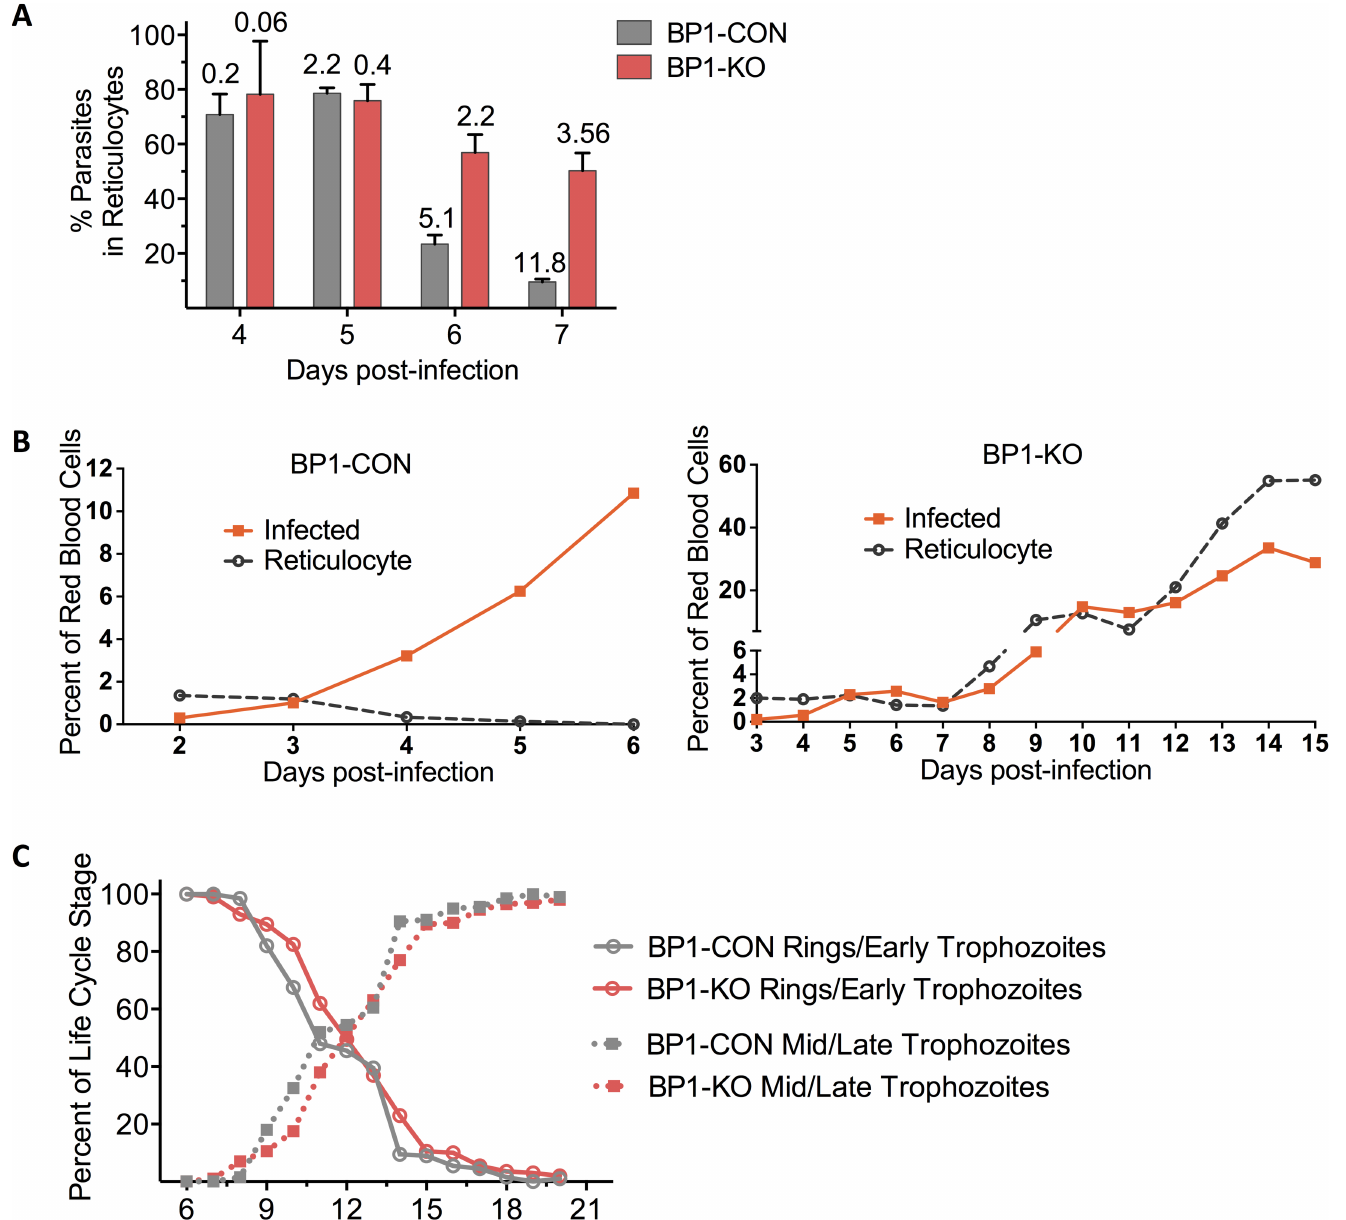
Fig 7. Berghepain-1 is important for normocyte invasion by blood stage parasites. A. Reticulocyte preference of berghepain-1 knockout parasites. Swiss Webster mice were infected with 10 4 purifiedBP1-CON and BP1-KO blood stage schizonts and infected normocytes and reticulocytes were counted starting 4 days after infection. Shown is the percentageof parasites found in reticulocyteson days 4–7 post infection. Each bar shows the mean plus standarddeviationof 5 mice (BP1-CON) and 10 mice (BP1-KO), the latter being pooleddata from BP1-KO clone 1 (5 mice) and BP1-KO clone 2 (5 mice). Mean total parasitemia values are displayedabovethe individualcolumns. B. Growth of BP1-KO but not BP1-CON blood stage parasites follow the reticulocyte count. Swiss Webster mice were injected i.v. with 2x10 5 BP1-KO or BP1-CON infected erythrocytes. Parasitemia and reticulocytemia were monitored daily by Giemsa-stained blood smears and the averageparasitemia of all survivingmice is plotted. n = 4 mice per group. C . Normal cell cycle length of berghepain-1 knockout parasites. Infections in Swiss Webster mice were started by i.v. injectionof 10 8 BP1-KO or BP1-CON synchronizedbloodstage schizonts. Parasitemia was monitoredhourly, counting ring stages and early trophozoites, and mid to late trophozoites. Percentage of each parasite life cycle stage is plotted as percent of total parasitemiaand pooledresults from two experiments using BP1-KO clone 1 are